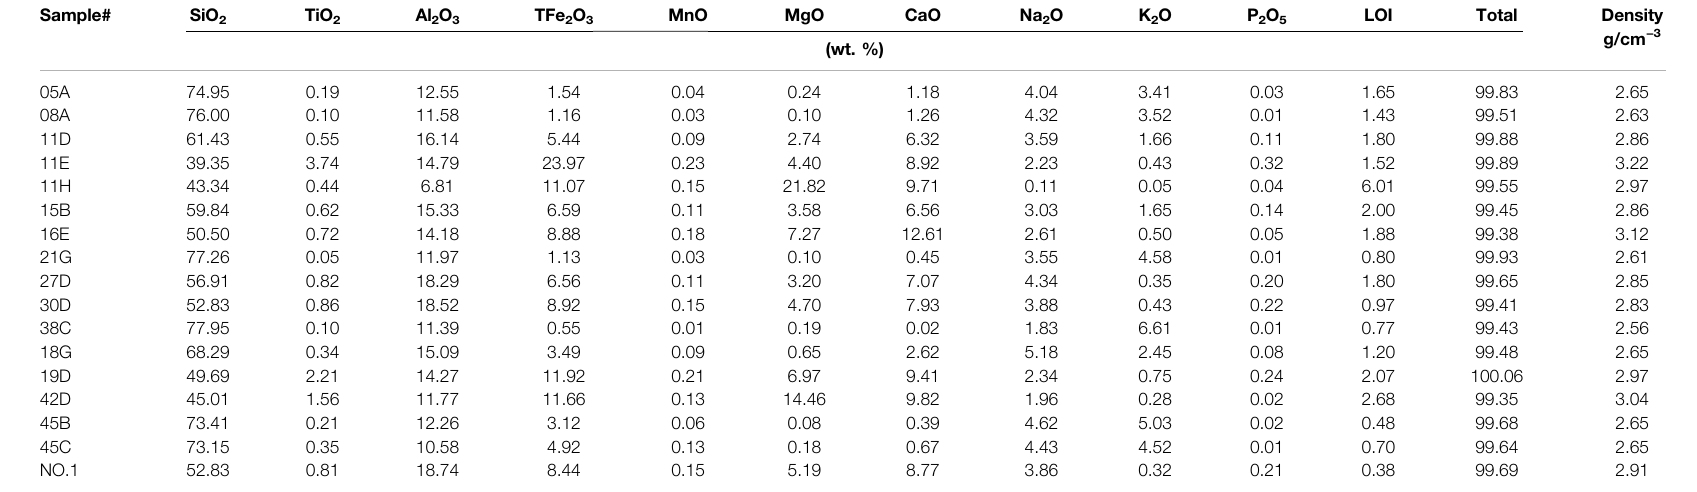
TABLE 1 | Chemical compositions and densities of the rock